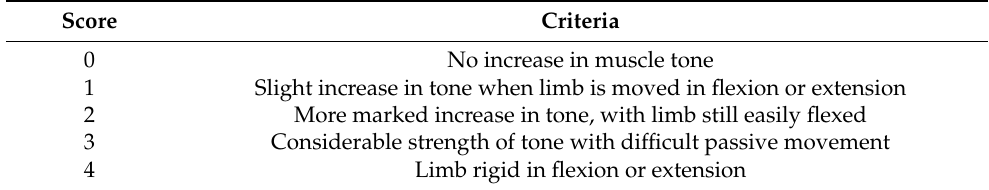
Table A2. Scoring for the Ashworth rating scale in rats after unilateral SCI.